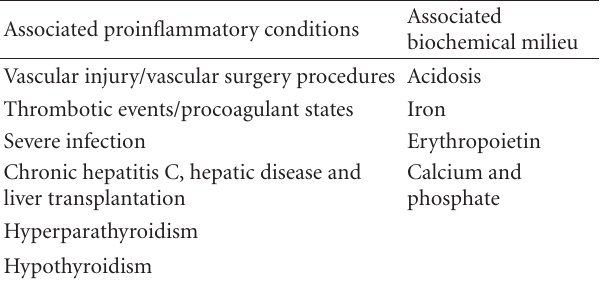
Table 1: Permissive factors presumably contributing to the devel- opment of NSF